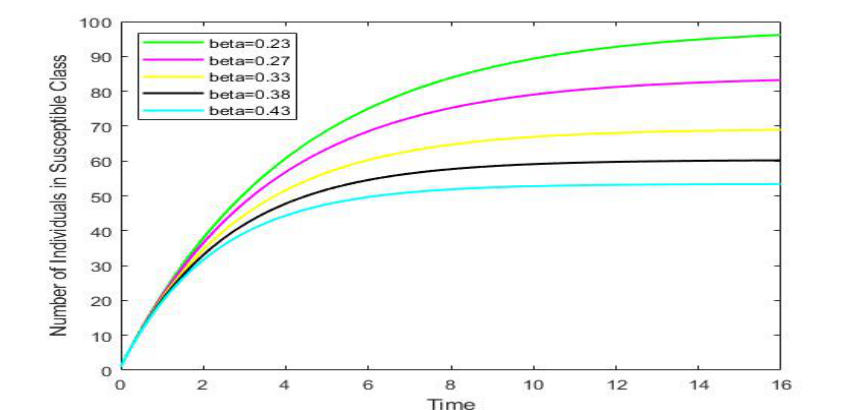
Figure 4: Flow of individuals in Susceptible Class for various values of β